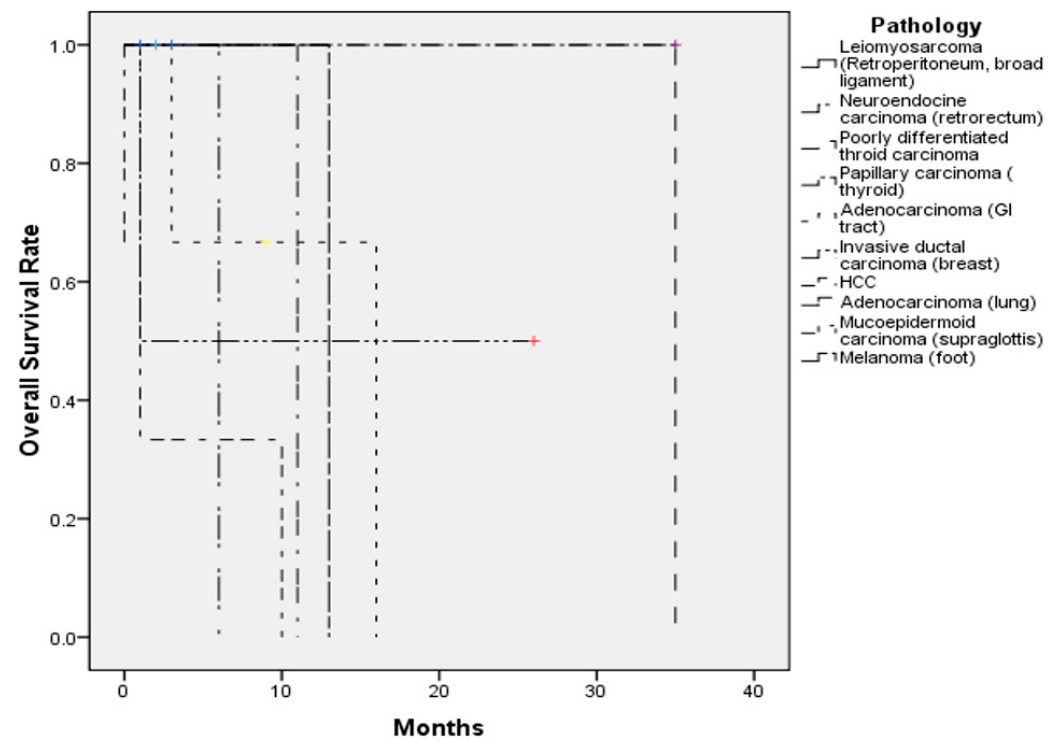
Figure 4. The overall survival of the 17 patients with sinonasal metastases in our